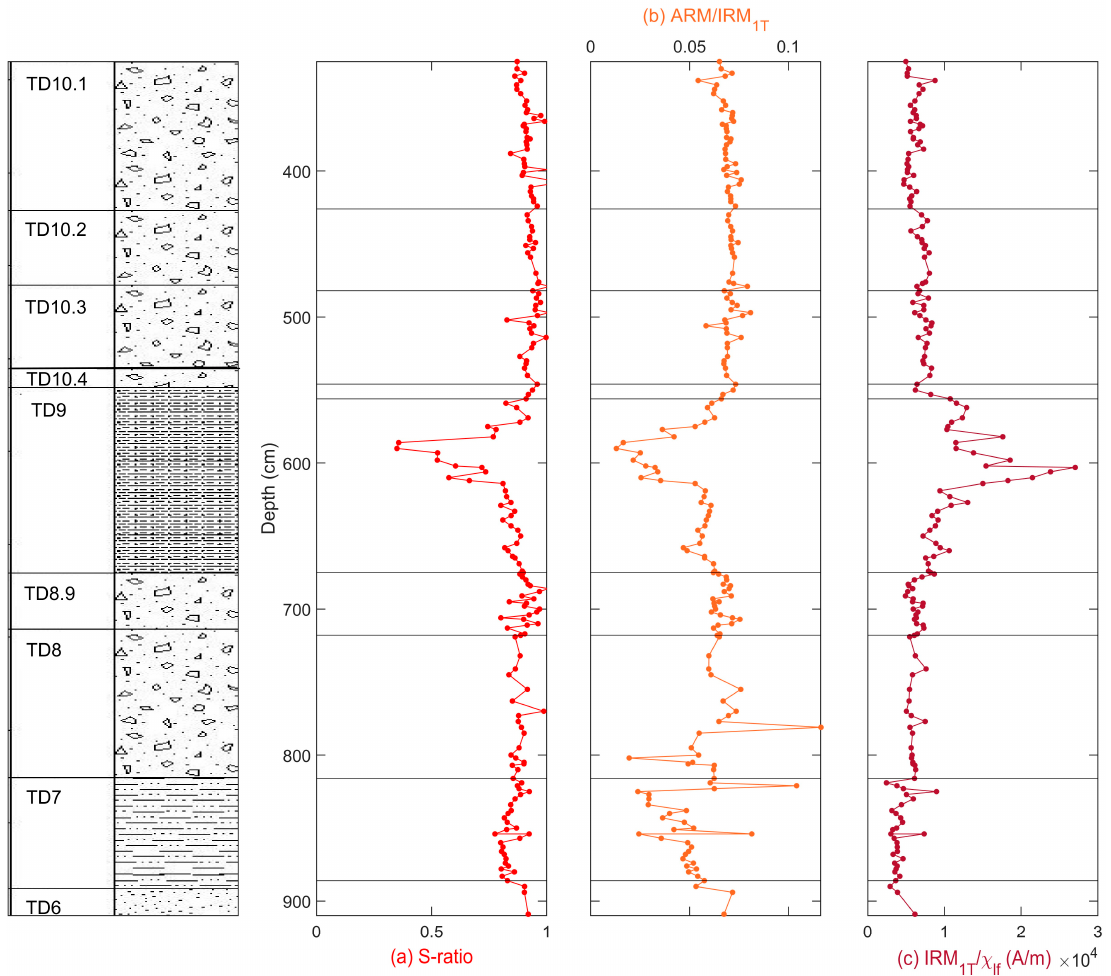
Figure 8. Characteristic ratios for grain size and mineralogical composition: ( a ) S-ratio, IRM 0 . 3T /IRM 1T ; ( b ) ARM/IRM 1T ; ( c ) IRM 1T / χ lf . Simpli fi ed stratigraphic log to the left.